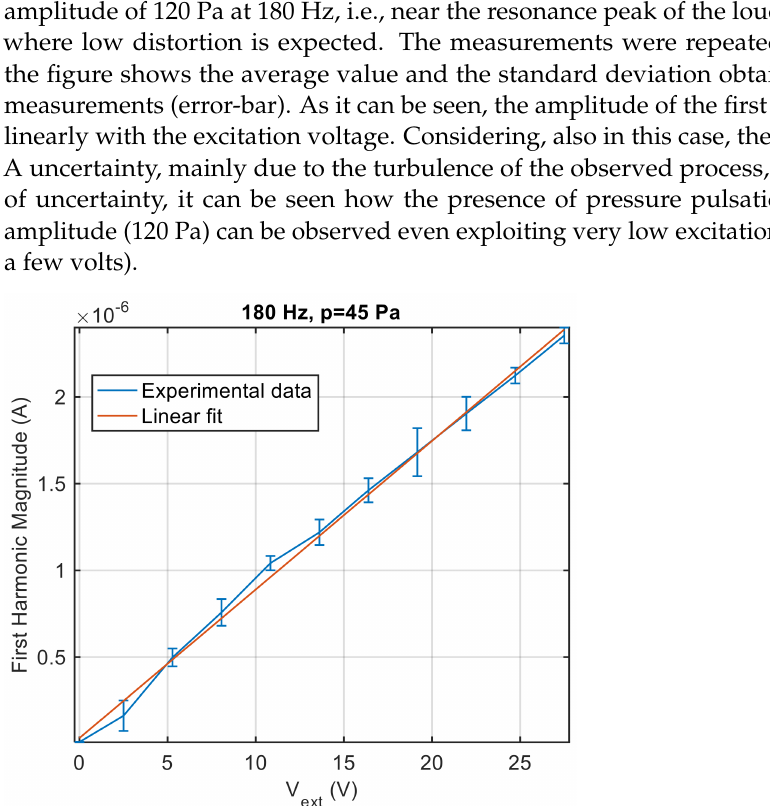
Figure 12. Peak magnitude of the ion current first harmonic as a function of the spark plug excitation voltage (peak-to-peak amplitude) with an acoustic pressure of 120 Pa at 180 Hz. Measured current values are the mean values obtained from seven repeated experiments, error bars represent the standard